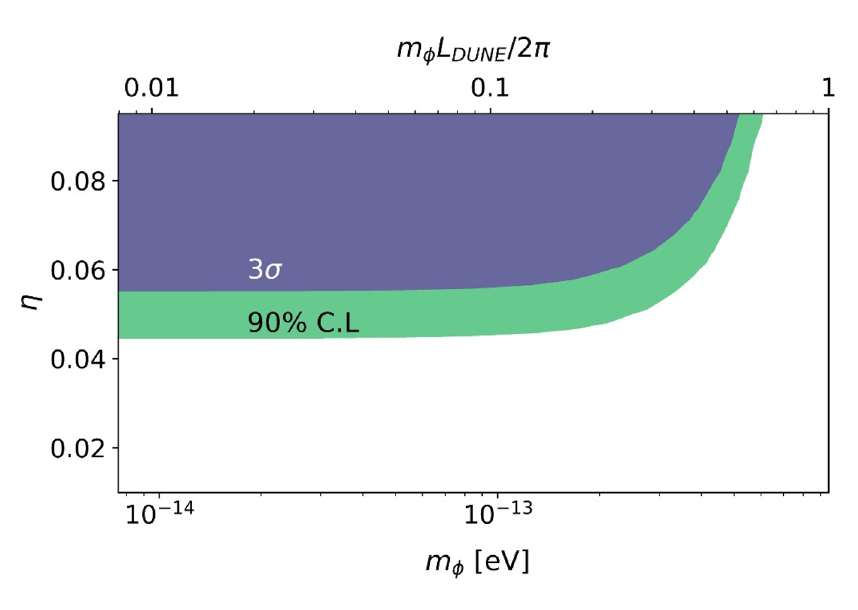
Figure 8 . DUNE sensitivity in a fast modulation of the ∆ m 2 versus the mass of the ultralight scalar m φ plane at 90 % C.L (green) and 3 σ (blue). Upper x-axis presents the corresponding range for the dimensionless quantity m φ L DUNE / 2 π